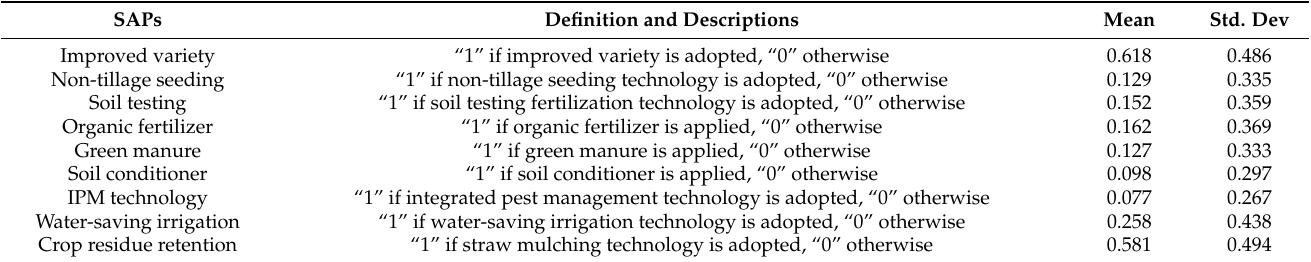
Table 2. Definition and descriptive statistics of nine